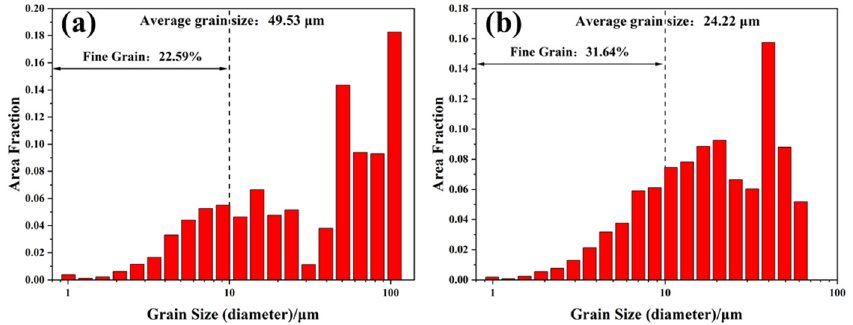
Figure 11. Statistical results of grain size on XY planes of Cu–Cr–Nb–Ti alloy samples manufactured using laser powers of ( a ) 300 W (P 300 V 800 ) and ( b ) 400 W (P 400 V 800 ) (scanning speed of 800 mm/s).